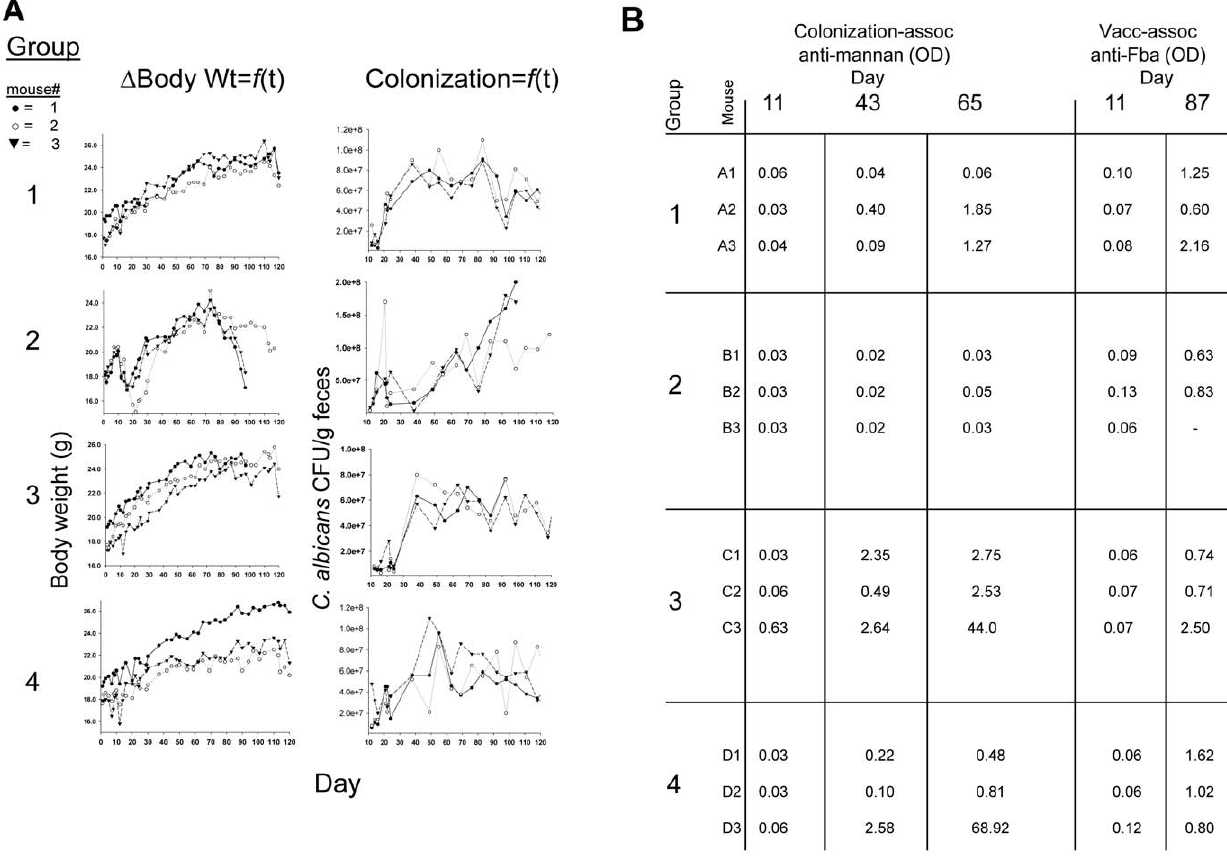
Figure 1. Body mass, GI-tract colonization and appearance of Candidaalbicans- specific antibodies as a function of time. Mice were given antibiotics in their water prior to and during ingestion of live C.albicans. Changes in body weight were monitored throughout the experiment, as was C. albicans colonization as measured by fungal colony forming units (CFU) per gram weight of feces (Panel A). One group was immunosuppressed (group 2) and all were followed for serum anti-mannan antibody induced as a result of GI-tract colonization. All mice were immunized and appearance of serum antibody against the vaccine immunogen, Fba, indicated whether they responded to the vaccine (Panel B, compare day 11 before vaccination to day 87 after vaccination). Groups 1 and 2 received antibacterial agents and fluconazole, but only group 2 was treated with cyclophosphamide. Group 3 was similar to 1, except that 3 did not receive fluconazole. Group 4 was not pretreated with antimicrobial agents prior to ingesting C. albicans, and this group was not maintained on gentamicin. Antibody responses were measured by ELISA for a 1:100 dilution of each serum and are expressed as OD 490nm. Shown are antibody responses at days 11, 43 and 65 to a mannan fraction ( a -mannan), which occurred as a result of GI-tract colonization, and antibody against Fba peptide, which occurred as a result of Fba vaccination (Panel B). In this experiment all mice were vaccinated on day 51 and boosted on days 65 and 79.